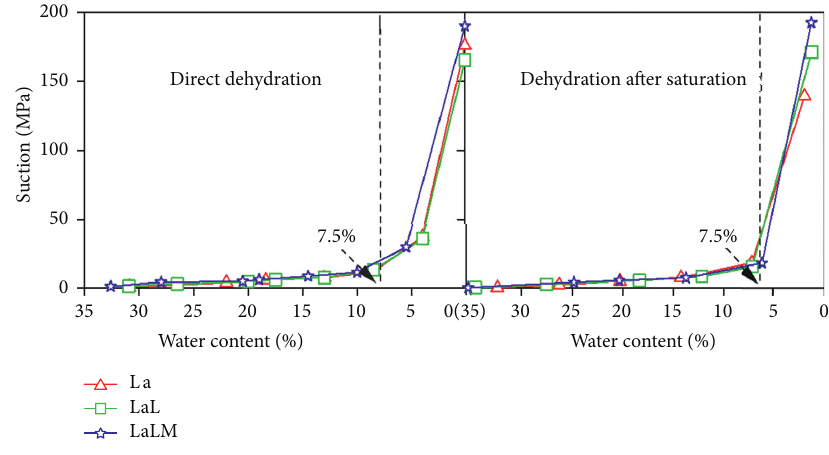
Figure 9: Suction as a function of water